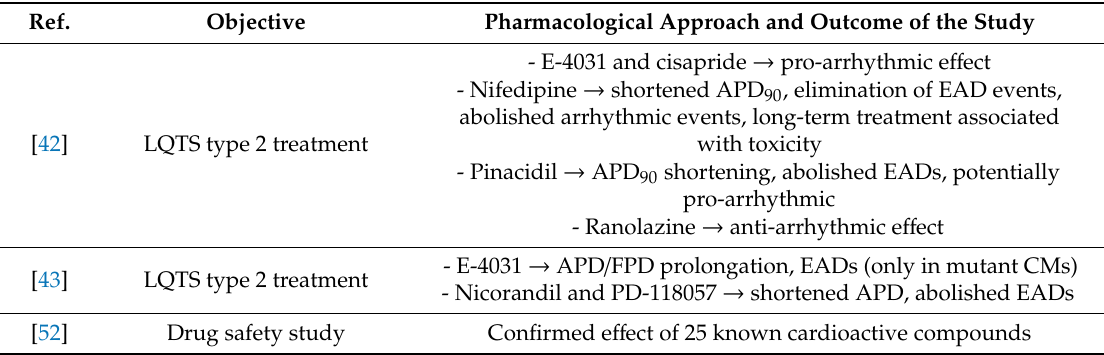
Table 1. List of 2D cardiac disease models for pharmacological studies described in this review.